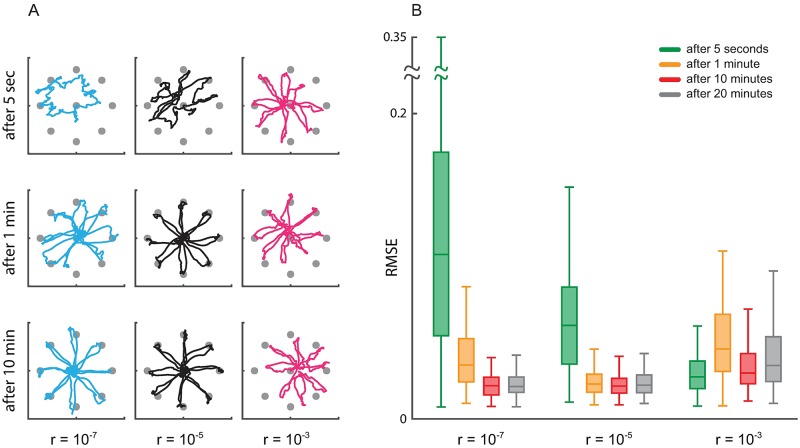
Learning rate calibration affects both the transient and the steady-state performance of closed-loop BMI decoders with discrete spiking activity.Figure conventions are the same as Fig 8. (A) The evolution of the decoded trajectory across time under different learning rates r. Each color corresponds to one learning rate. As in Fig 8, the decoder is fixed after a given adaptation time is completed (as noted on each row). The fixed decoder is then used to generate the displayed trajectories. The decoding performance is unstable when the learning rate is large (r = 10−3), i.e., the performance widely oscillates. (B) RMSE of the decoded trajectory under different learning rates for different adaptation times. RMSE is computed for a fixed decoder that was obtained by stopping the adaptation at various times (different colors). RMSE converges faster as the learning rate is increased (r = 10−7 to 10−5, for example). However, if the learning rate is selected too large (r = 10−3), RMSE oscillates without converging to a stable number. These results again demonstrate the importance of calibrating the learning rate for fast convergence and accuracy of decoding.